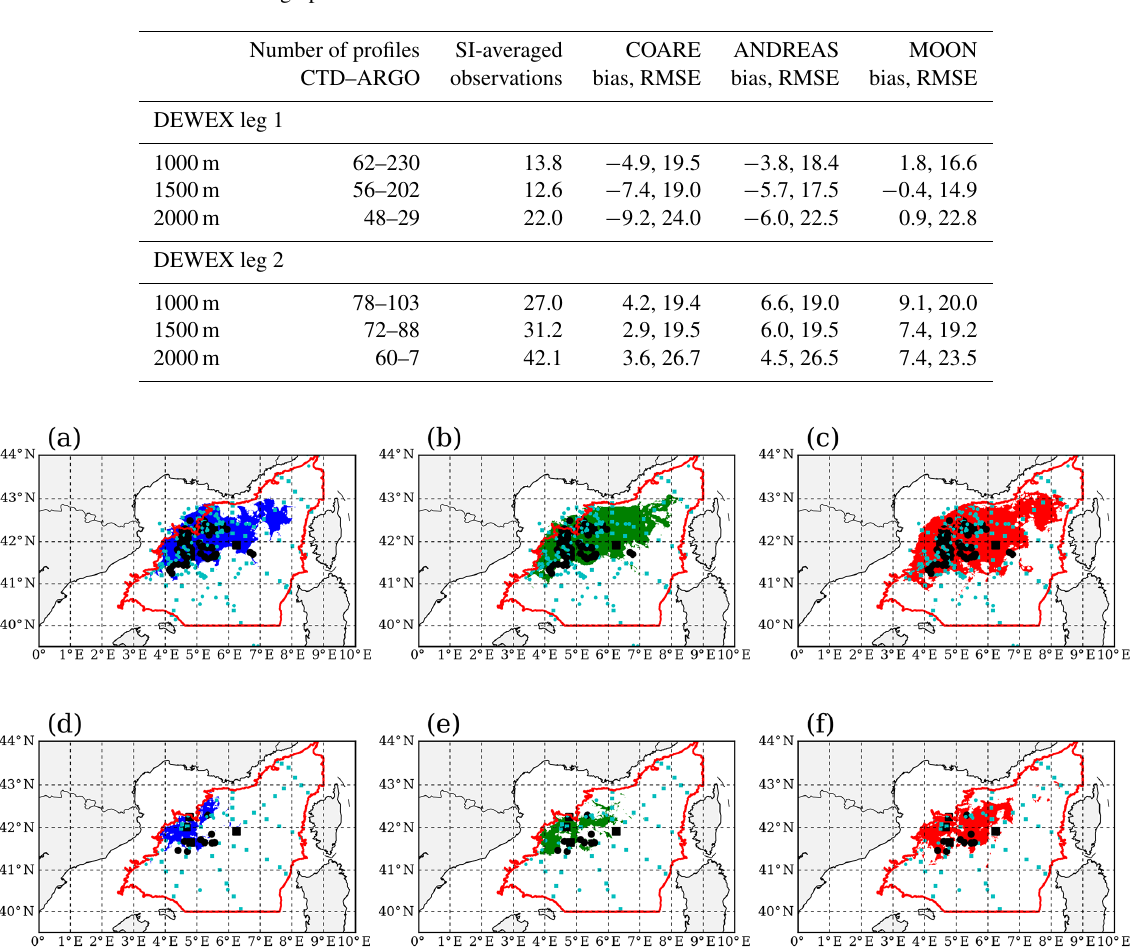
Table 3. Number of CTD–ARGO observed profiles, observations averaged, simulations bias and RMSE averaged, for SI (kgm − 2 ) at 1000, 1500 and 2000m for DEWEX oceanographic cruises.